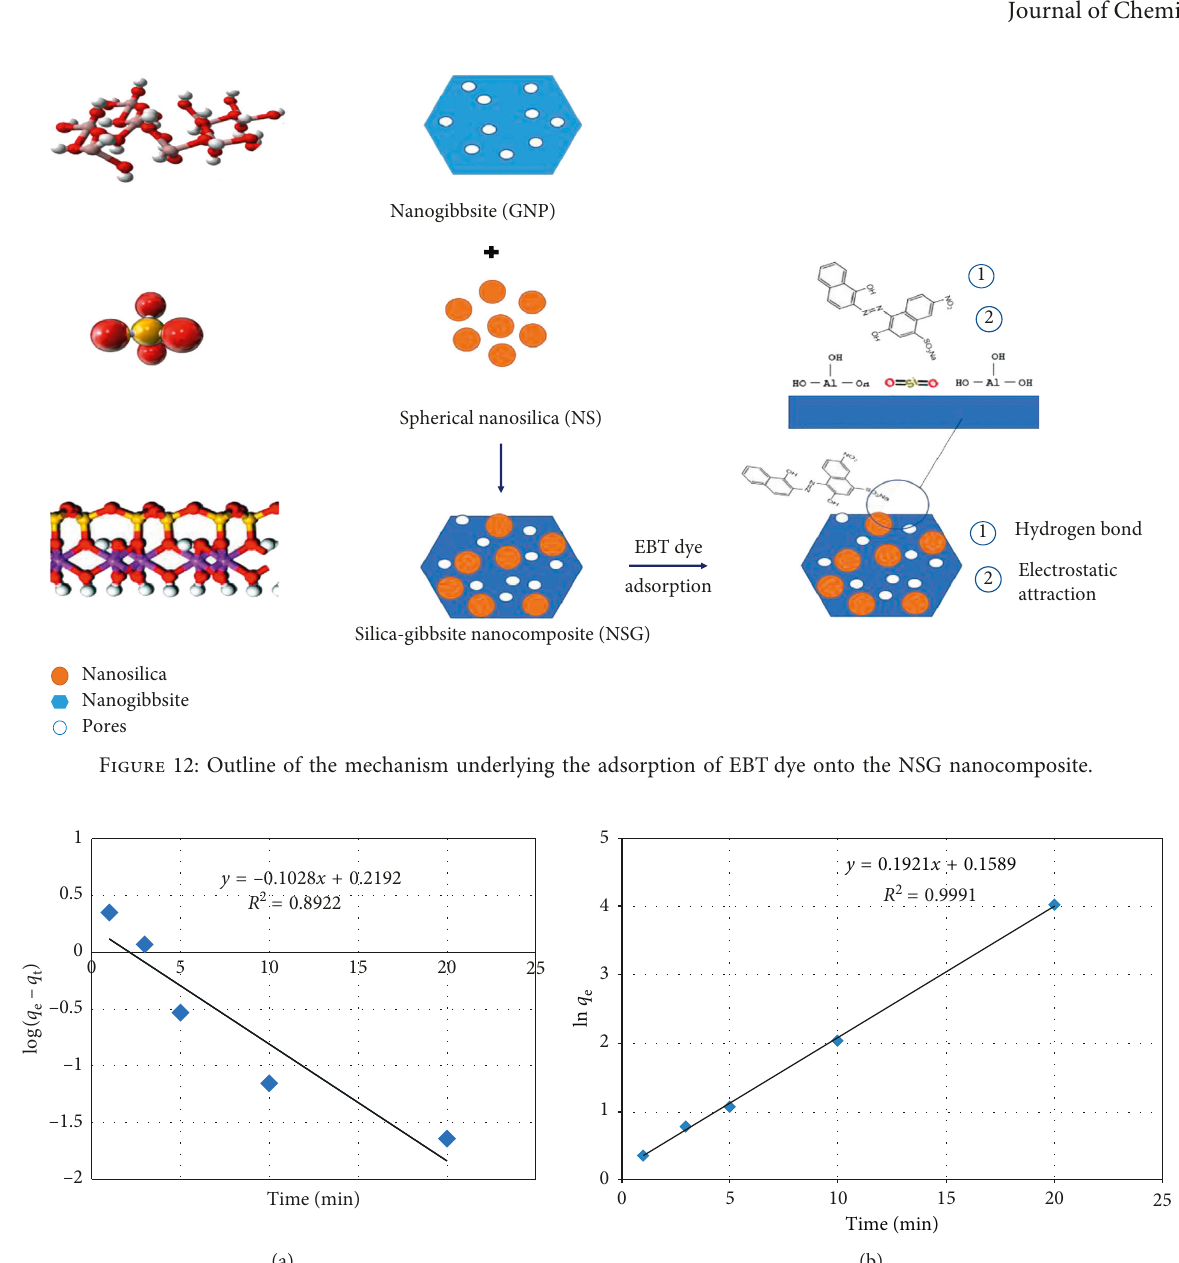
Figure 13: The adsorption kinetics. (a) The pseudo first-order equation and (b) the pseudo second-order equation for the adsorption of Table 3: Parameters of the pseudo first-order (PFO) and pseudo second-order (PSO) kinetic models developed for the adsorption